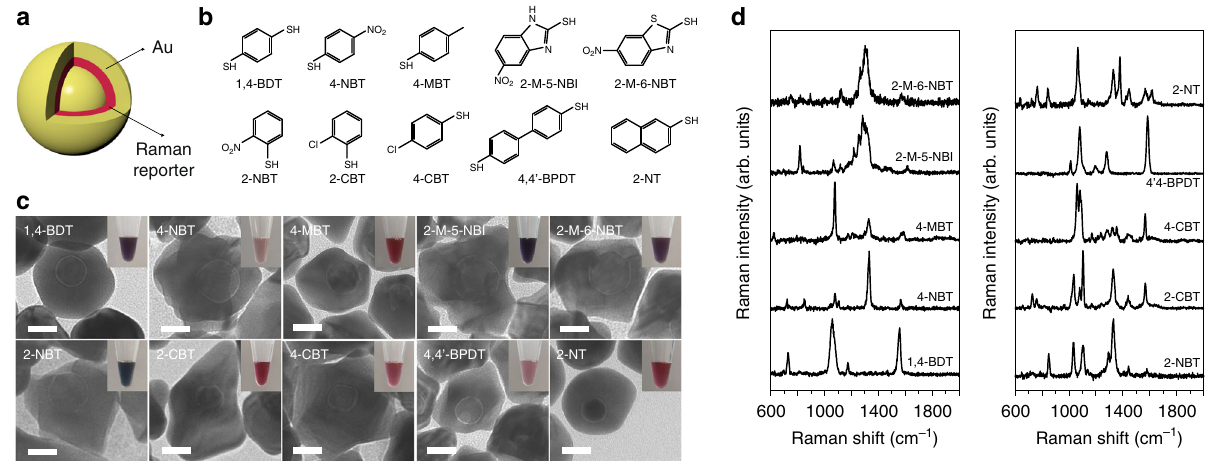
Fig. 2 SERS NPs with embedded Raman reporters, termed as gap-enhanced Raman tags (GERTs), used for fabricating Raman PUF labels. a Schematic representation of a GERT. b Molecular structures, c transmission electron microscopic (TEM) images, and d SERS spectra of ten GERTs with different embedded reporter molecules. Insets in c are the corresponding photos of various GERT solutions. All scale bars are 20